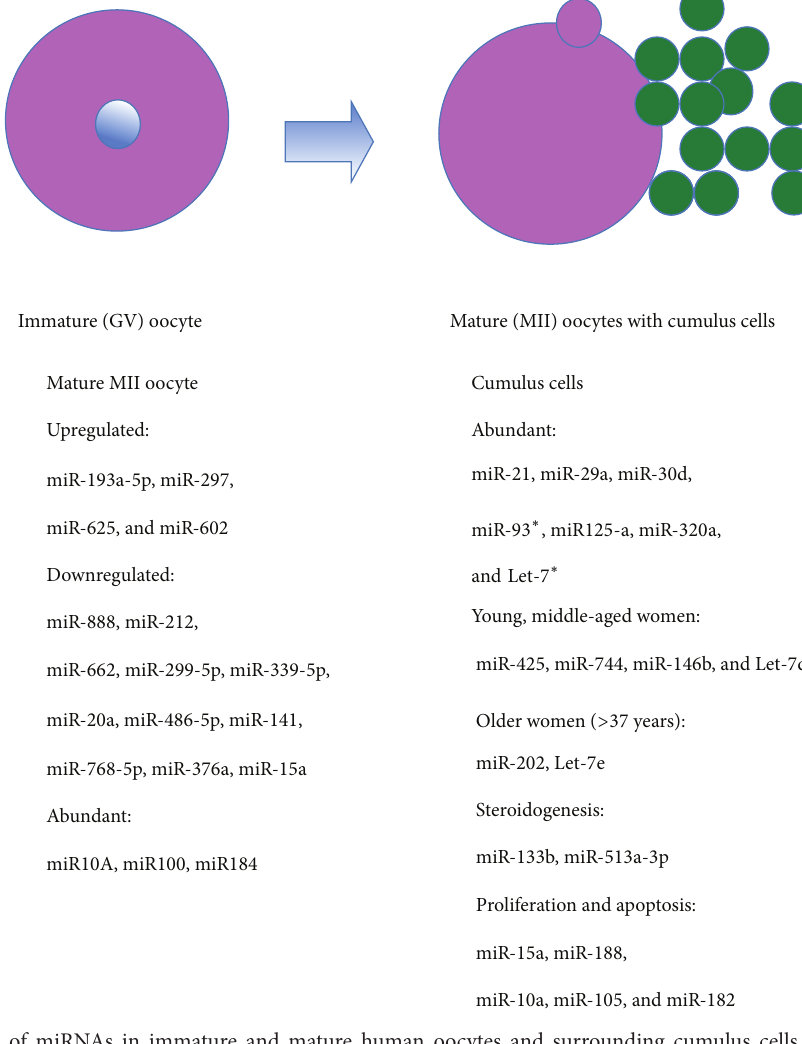
Figure 2: Comparison of miRNAs in immature and mature human oocytes and surrounding cumulus cells according to female age, steroidogenesis, proliferation, and apoptosis [28, 29, 33, 40, 41, 45–47]. Legend: ∗ miRNAs which are also abundant in the mouse cumulus